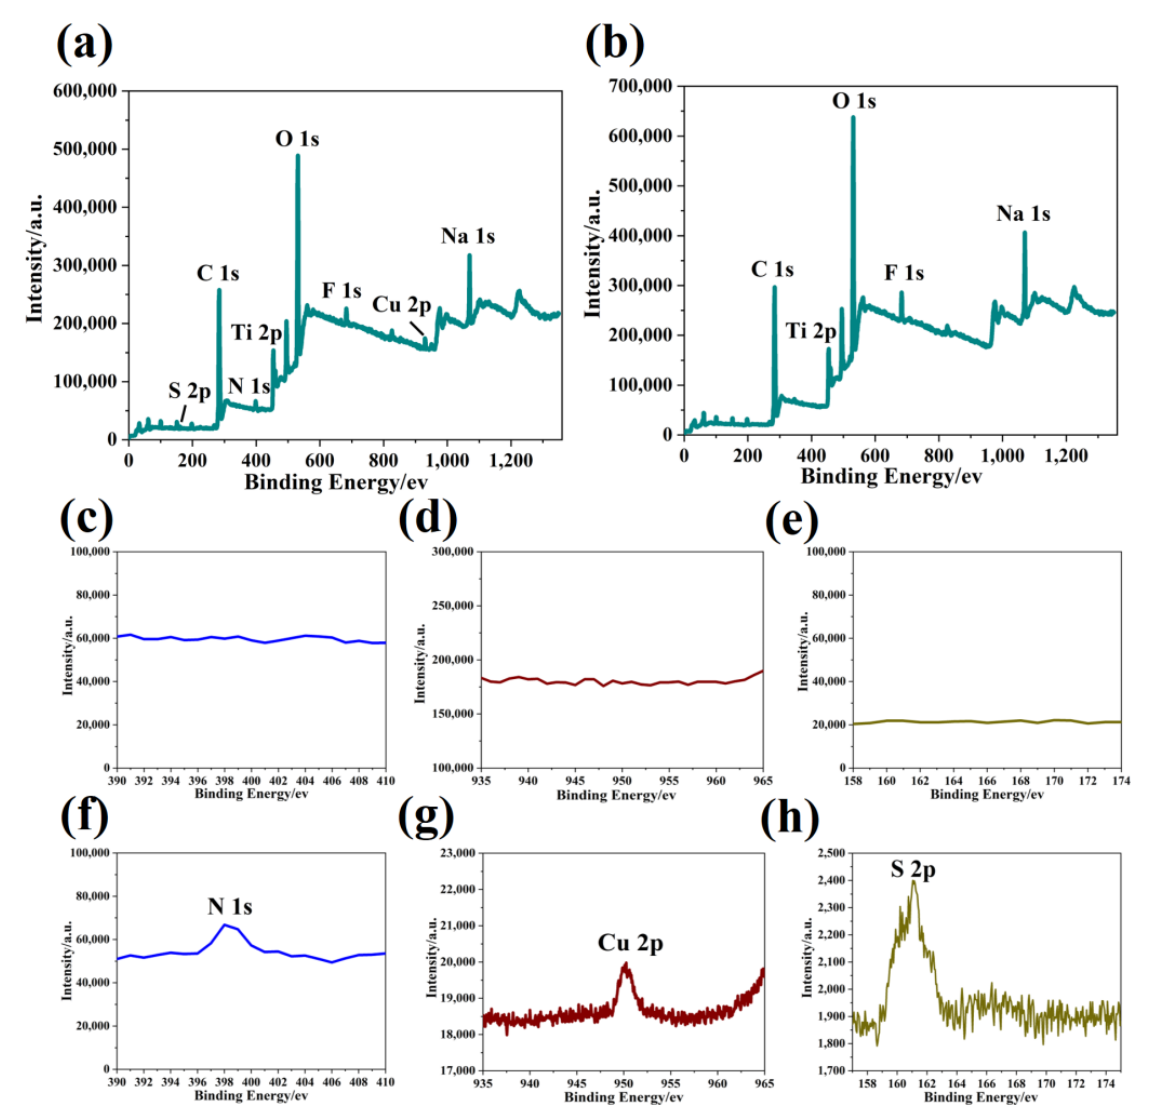
Figure 3. XPS characterization of CuS-PNS/Ti 3 C 2 nanohybrids: ( a ) XPS survey spectrum of CuS- PNSs/Ti 3 C 2 ; ( b ) XPS spectrum of Ti 3 C 2 ; ( c – e ) XPS spectra of N, Cu, and S in Ti 3 C 2 ; ( f – h ) XPS spectra